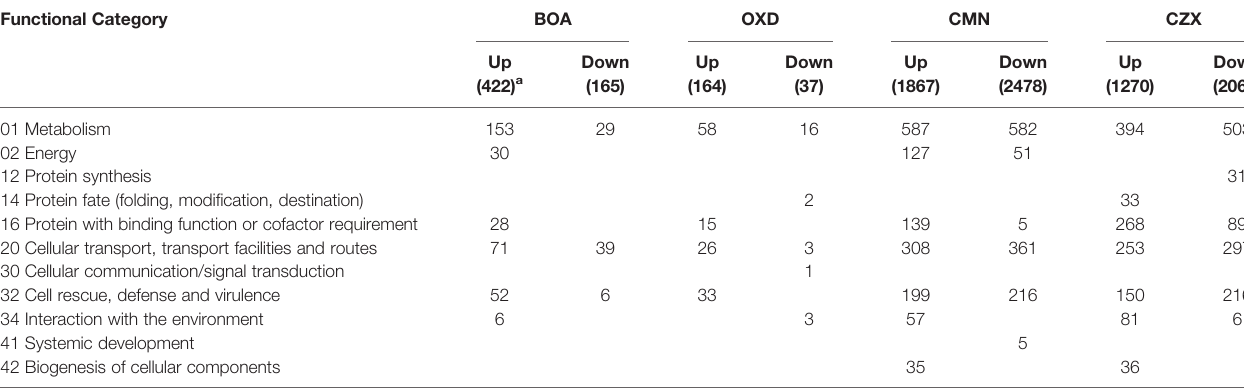
TABLE 9 | MIPS functional categorizations for genes differentially regulated in response to BOA, OXD, CMN, and CZX. Functional